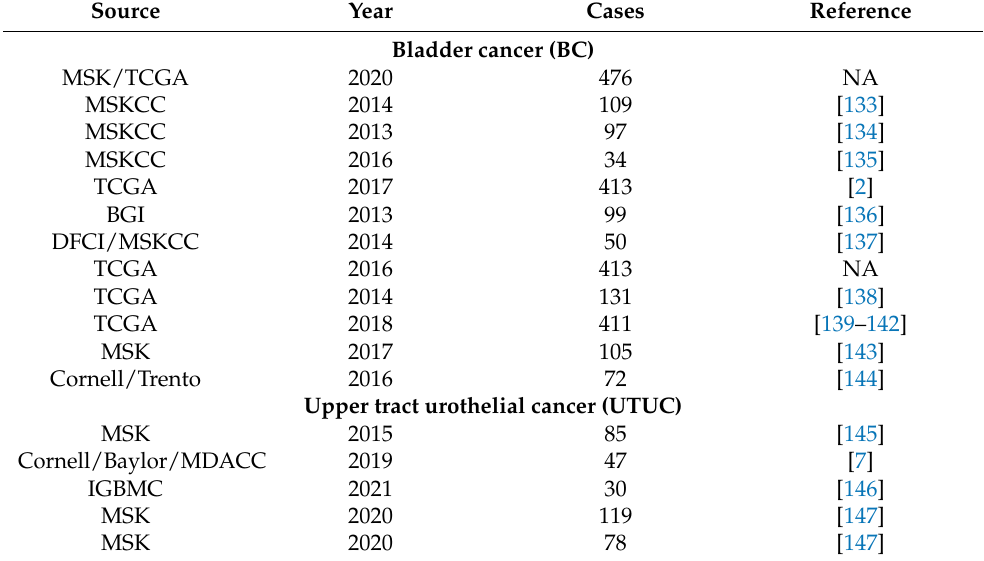
Table 2. Available studies for visualization and analysis of urothelial cancer (bladder/upper tract). All data and their corresponding clinical parameters were obtained through whole-exome or RNA sequencing approaches. These clinical cohorts were collected from the cBioportal website and previous studies. Please refer to the original references or cBioportal website for the definition of